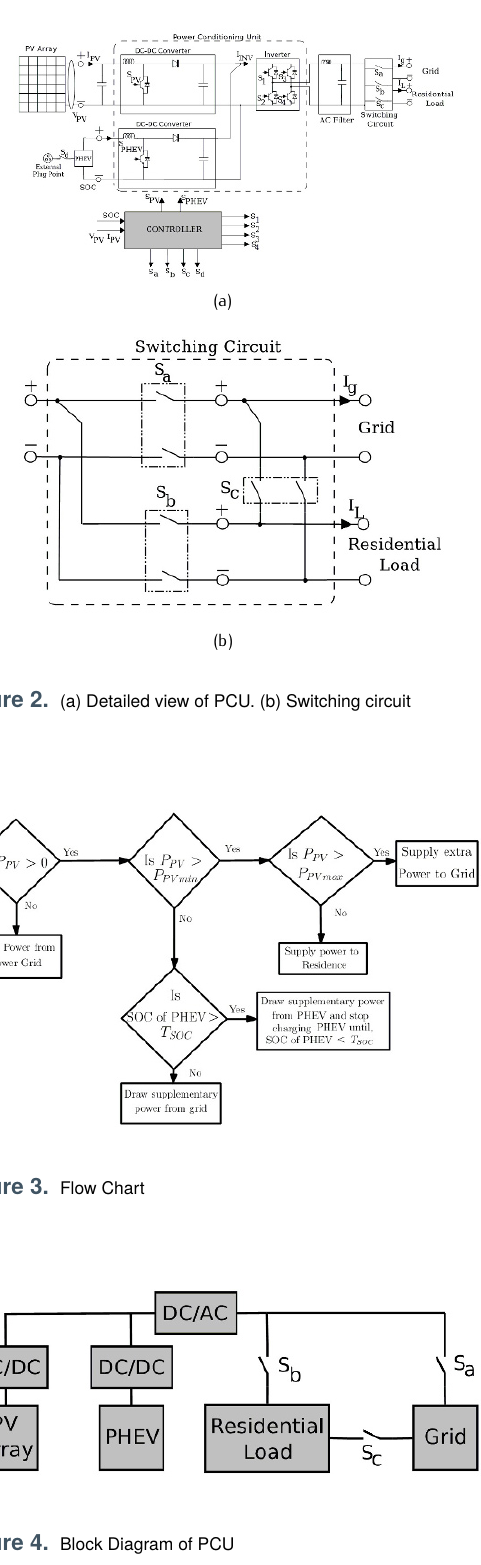
Figure 4. Block Diagram of